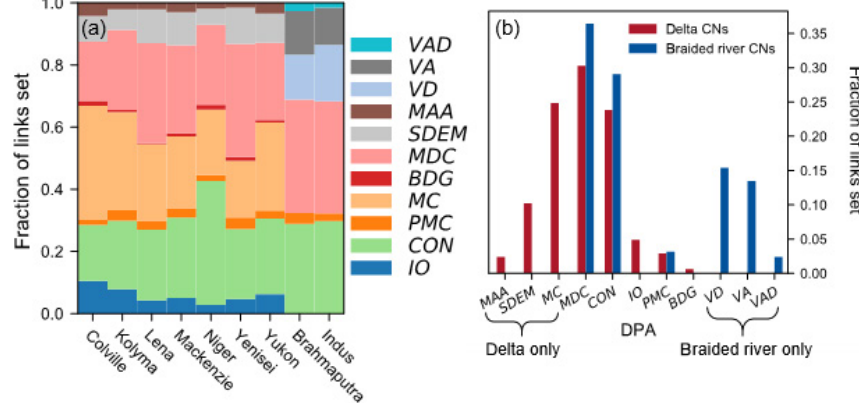
Figure 6. DPA effectiveness. (a) Fraction of links set by each DPA for each study CN. DPAs are defined as follows. VAD – valley angle and distance, VA – valley angle, VD – valley distance, MAA – multiple DPAs agree, SDEM – synthetic DEM, MDC – minimize direction change, BDG – bridge links, MC – main channels, PMC – parallels to main channels, CON – continuity, and IO – inlet/outlet links. (b) Fraction of each DPA for all CNs; red (and blue) bars sum to